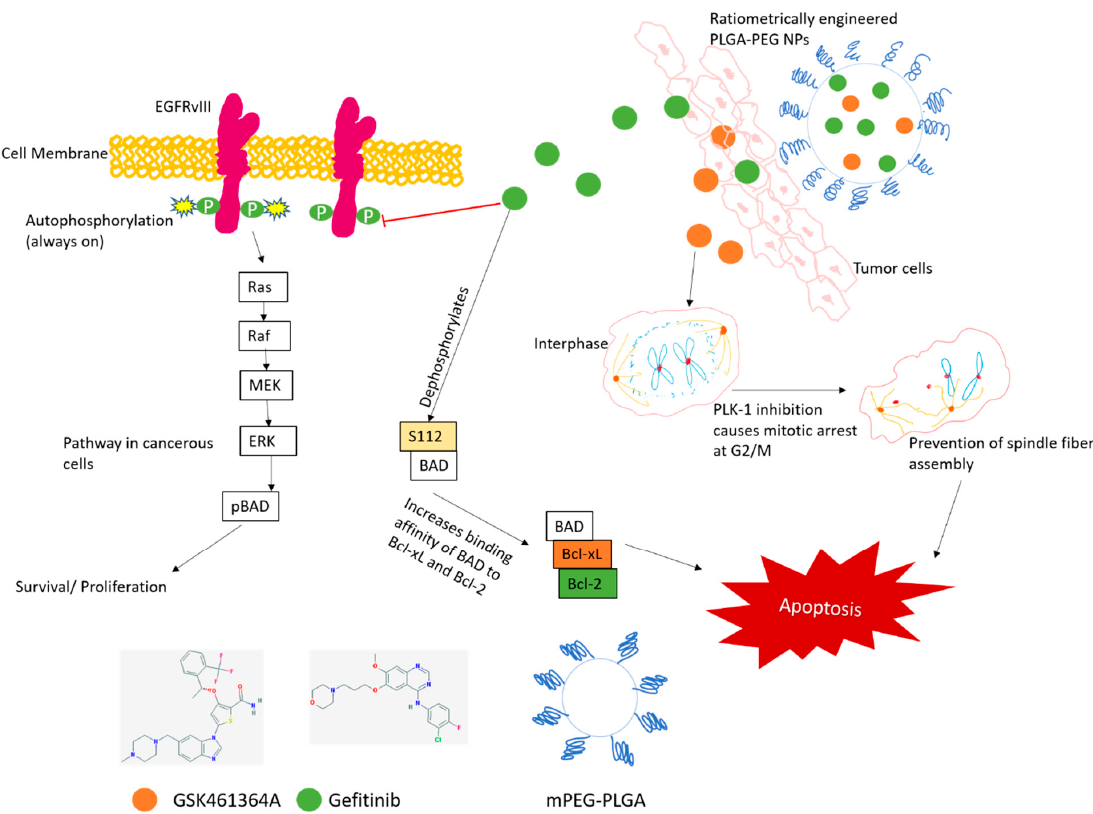
Figure 1. Proposed mechanism of action of dual drug loaded poly (lactic-co-glycolic) acid and polyethylene glycol (PLGA-PEG) nanoparticles and their effect on U87-MG cells. The chemical structure of gefitinib and GSK461364A were obtained from Pubchem. NPs: Polymeric nanoparticles; EGFR: epidermal growth factor receptor; BAD: Bcl-2 associated death promoter; MEK: Mitogen activated protein kinase kinase; ERK: Mitogen activated protein kinase